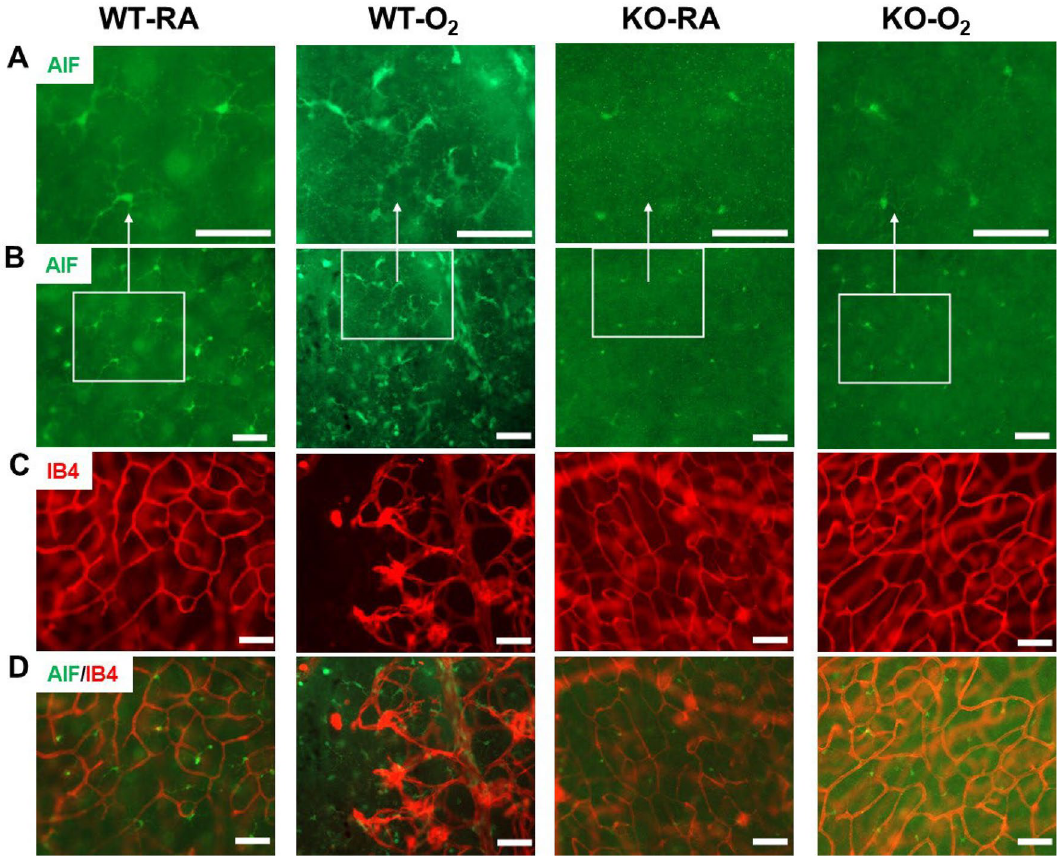
Figure 9. GSDMD-KO prevents hyperoxia activation of microglia in the retina. Double Immunofluorescent staining for allograft inflammatory factor 1 (AIF1), a microglial marker (green signals), and IB4, a vascular marker (red signals), was performed to assess microglial expression and activation in retinas. ( A , B ) The microglia cells in the WT-O 2 retinas were disorganized and had enlarged bodies and dendrites compared to retinas from WT-RA, KO-RA, and KO-O 2 mice. ( A ) Representative focal enlarged areas of ( B ) in the white boxes. ( C ) The vessels in the WT-O 2 retinas were less, blunt, and disorganized compared to the other three groups. ( D ) Merging of ( B ) and ( C ) showed that activated microglia were in abundance in the avascular area of the retinas from WT-O 2 mice. 20 × magnification. Scale bar: 50